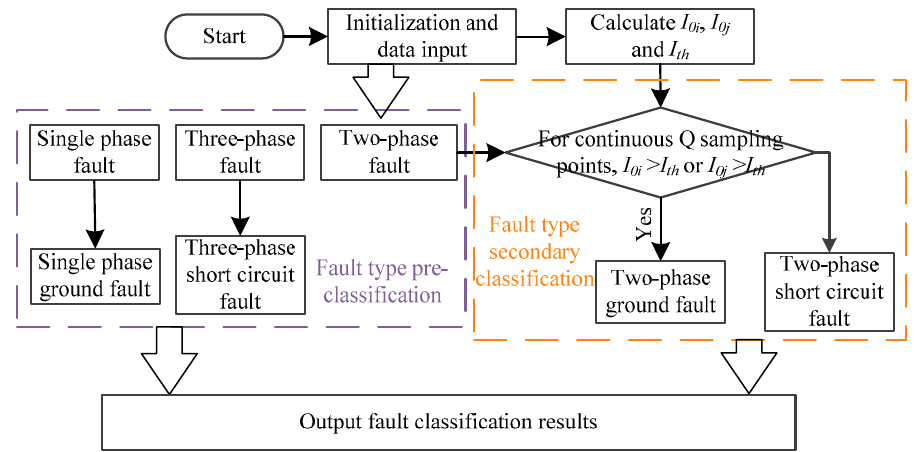
Figure 6. Flow chart of fault